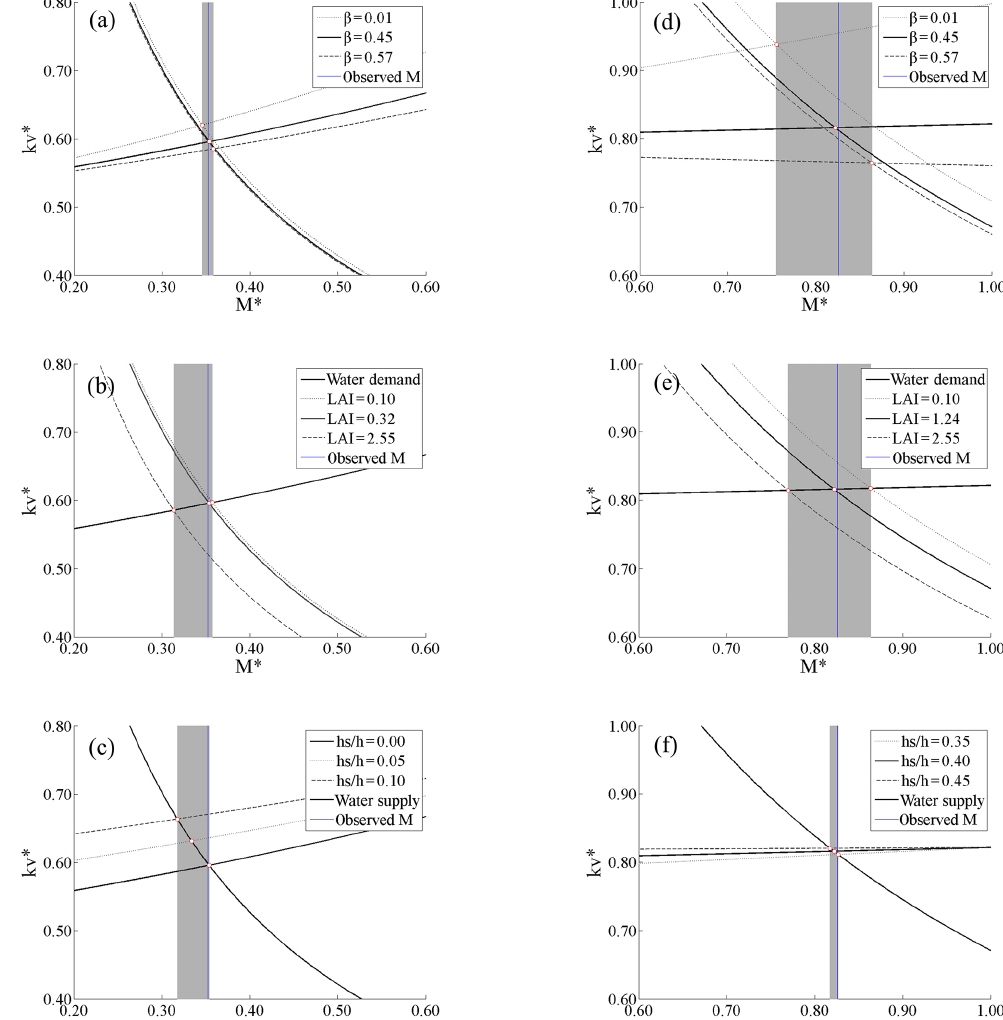
Figure 5. M ∗ changes with β , LAI and h s /h : (a) – (c) grassland; (d) – (f) forest. The shaded areas indicate the range of M ∗ with the change of climate